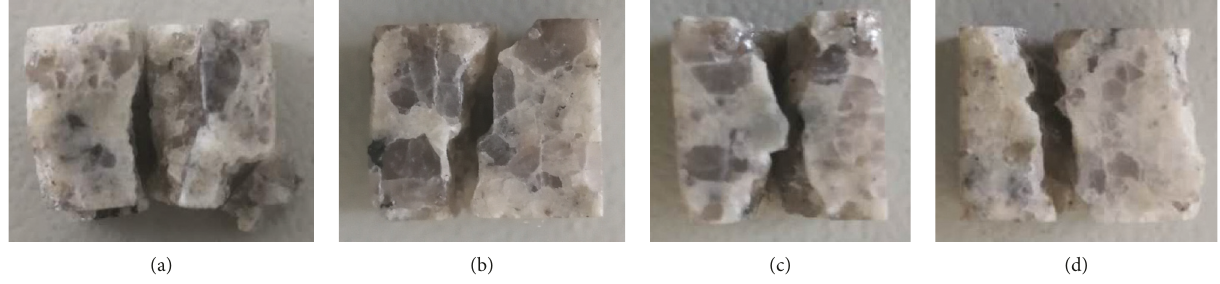
Figure 13: Fracture morphology of the